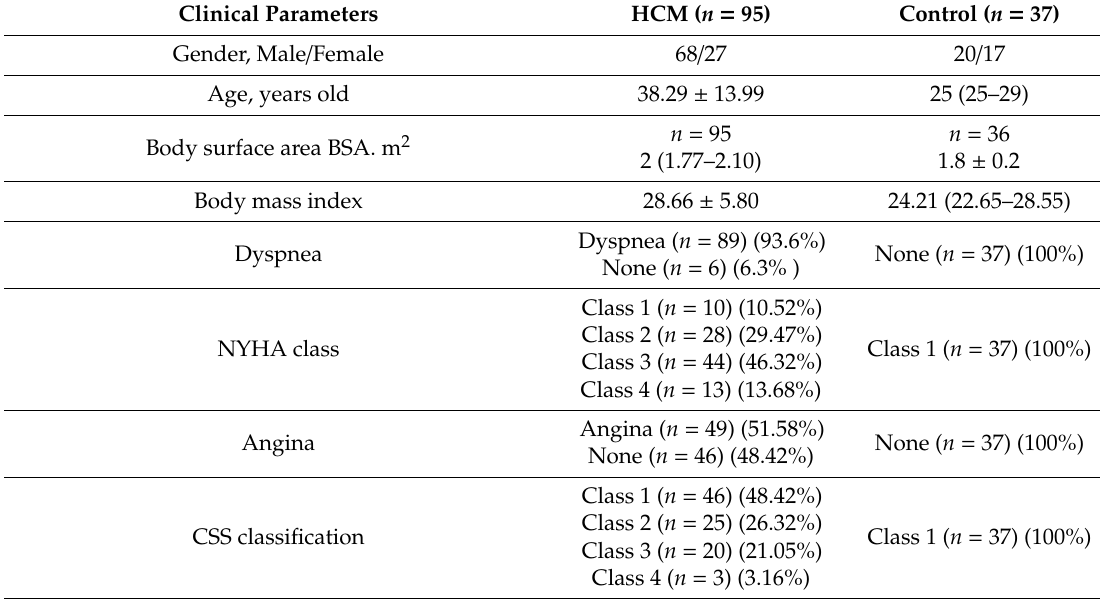
Table 1. Clinical characteristics of hypertrophic cardiomyopathy (HCM) and normal control